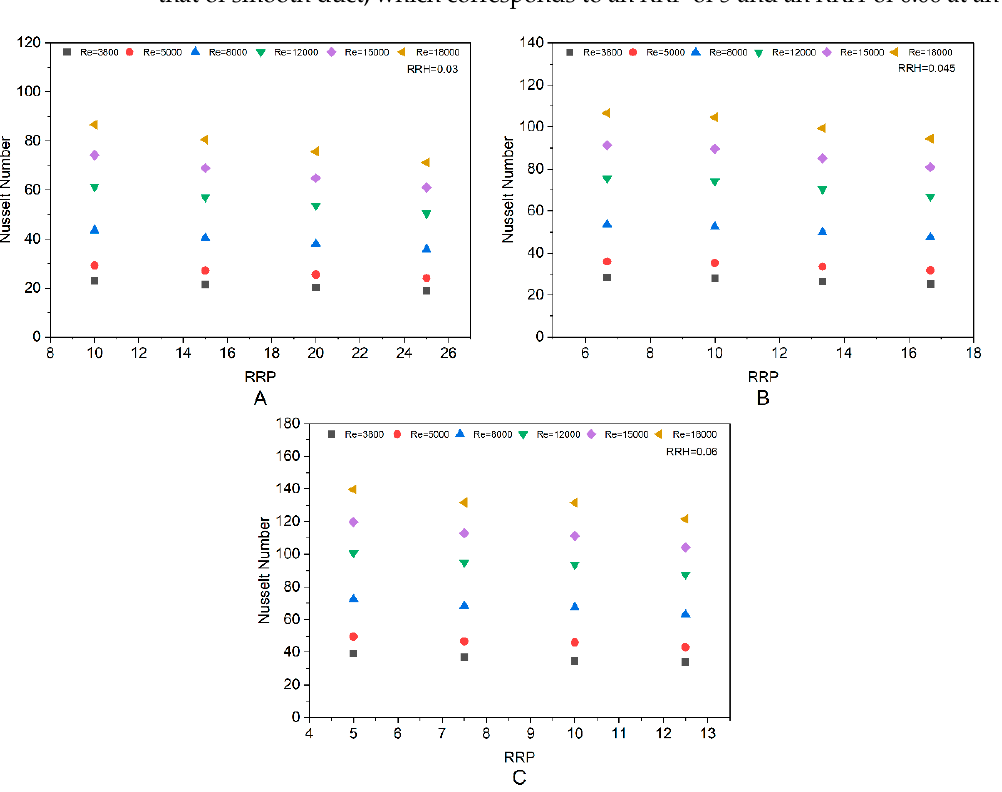
Figure 10. Nu r versus Re for ( A ) RRH = 0.03, ( B ) RRH = 0.045, and ( C ) RRH = 0.06.